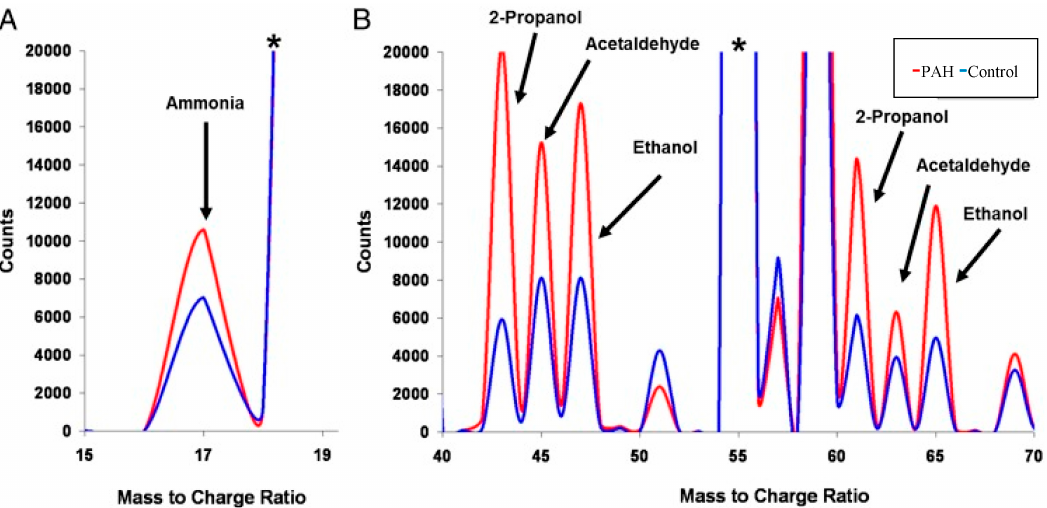
Figure 2. Representative selected ion flow tube mass spectrometry (SIFT-MS) chromatogram for the pulmonary arterial hypertension (PAH) and control cohort groups [137]. Labeled peaks correspond